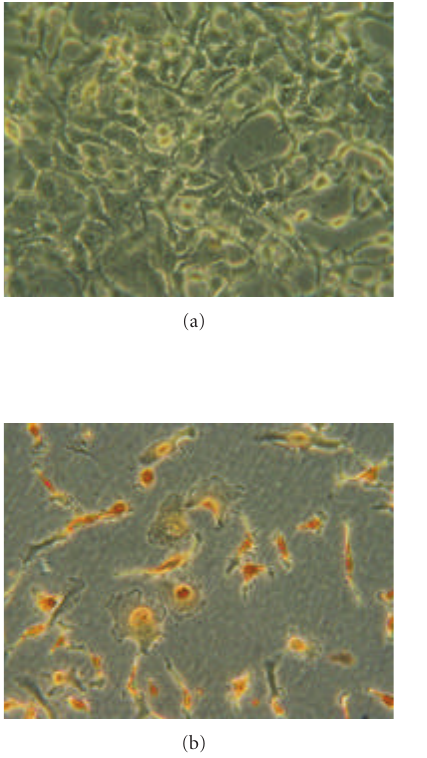
Figure 5: Apoptosis in human keratinocytes NCTC 2544 treated with clofibrate. Twenty four hours after seeding, cells were treated with 250 μ M clofibrate for a further 48hrs. Control cells were treated with vehicle alone. Apoptosis was determined by TUNEL staining. Panel A, control cells; Panel B, cells treated with clofibrate.